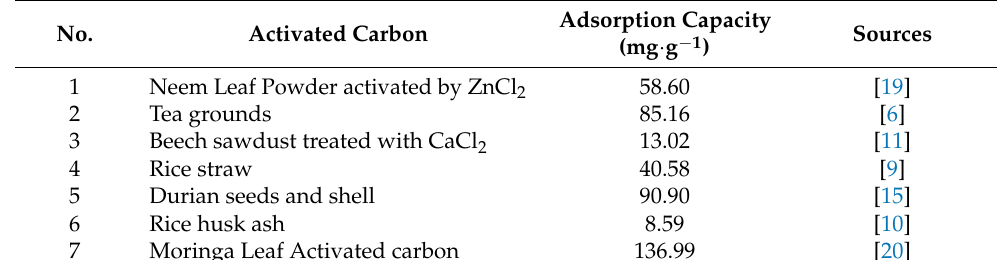
Table 4. Maximum MB adsorption capacity (q max ) of ACDS activated carbon and some plant biomass activated carbons.